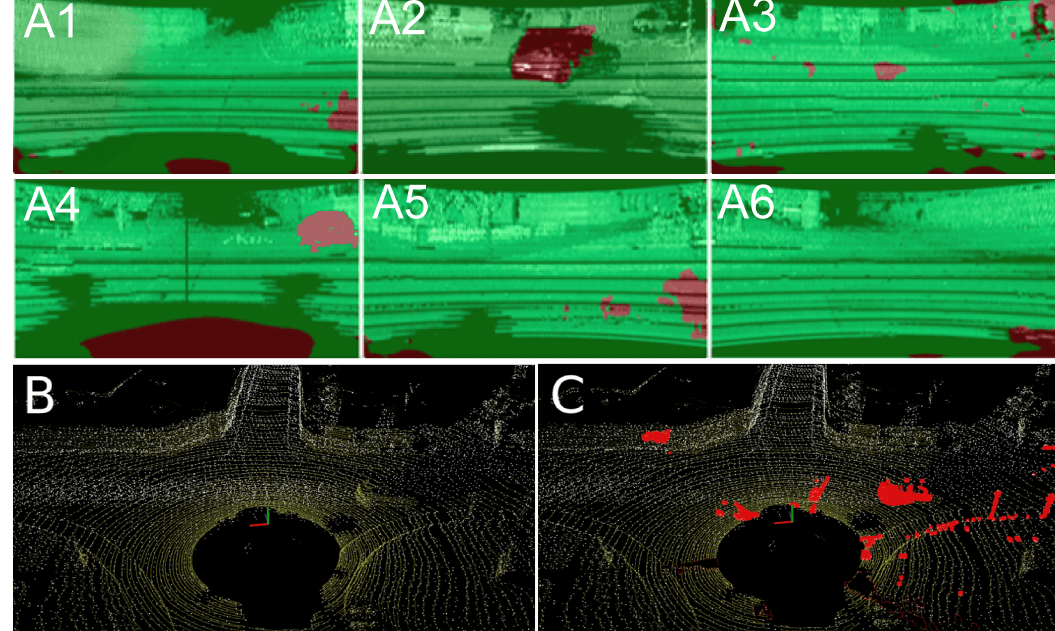
Figure 10. Motion segmentation of a 360 ◦ Velodyne HDL-64E scan ( A ). Map (white points) created without ( B ) and with removing of non-stationary objects ( C ). Current laser scan is shown in yellow and rejected points in